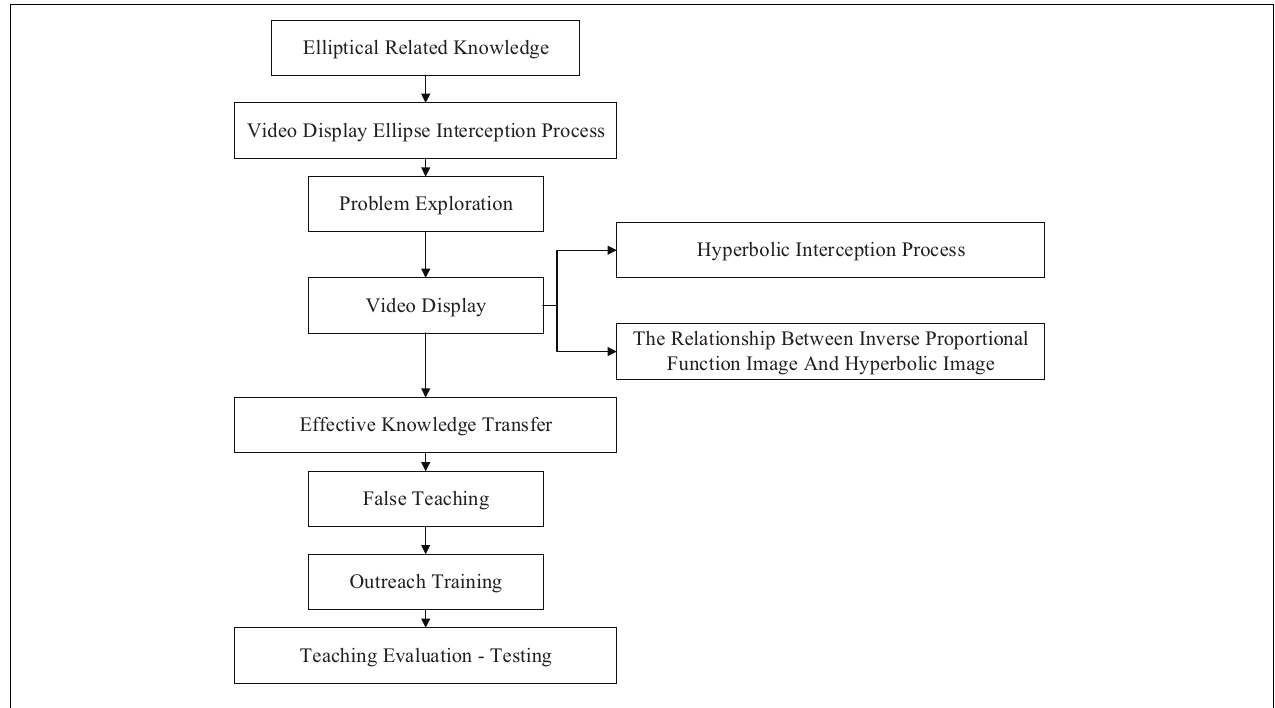
FIGURE 6 | The education modes based on two different methods.